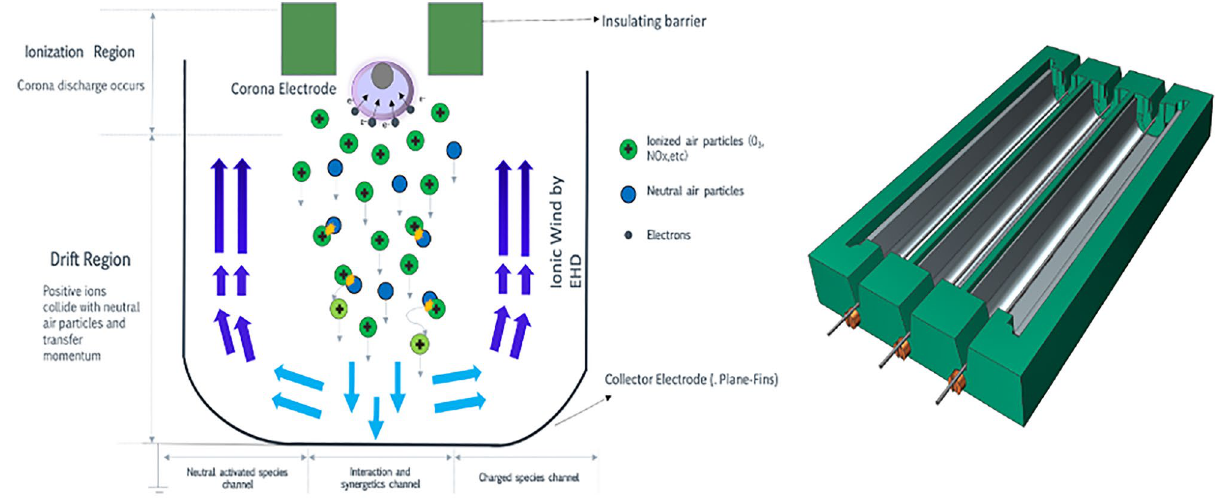
Figure 1. Schematic diagram of positive corona discharge and CAD design of TRAID configuration 3